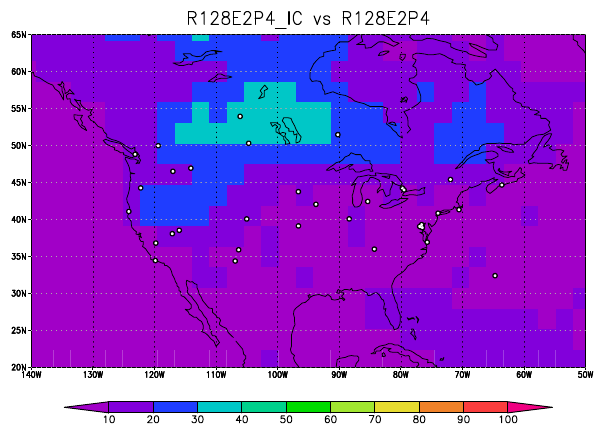
Fig. 10. Time-averaged differences [%] in AOT, for the spinup experiment. The black & white dots represent AERONET sites.